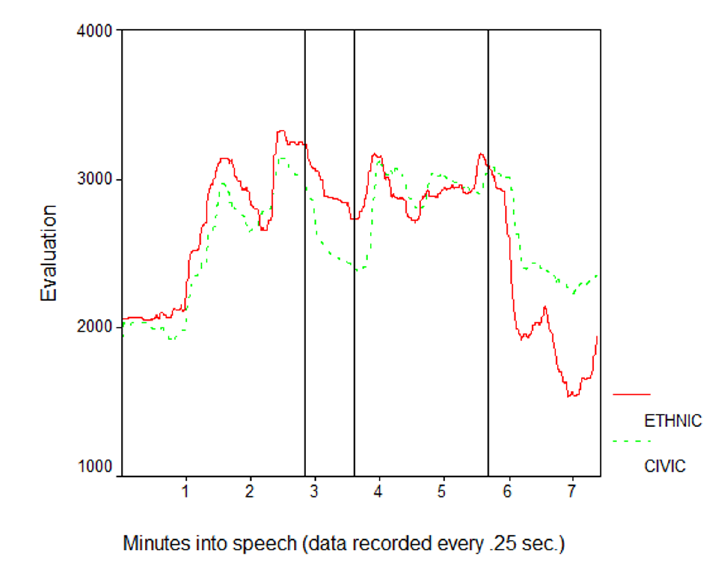
Figure 1. Study 3: Continuous (mean) evaluations of the speaker in the ethnic and civic conditions throughout the four phases of the speech (higher identifiers